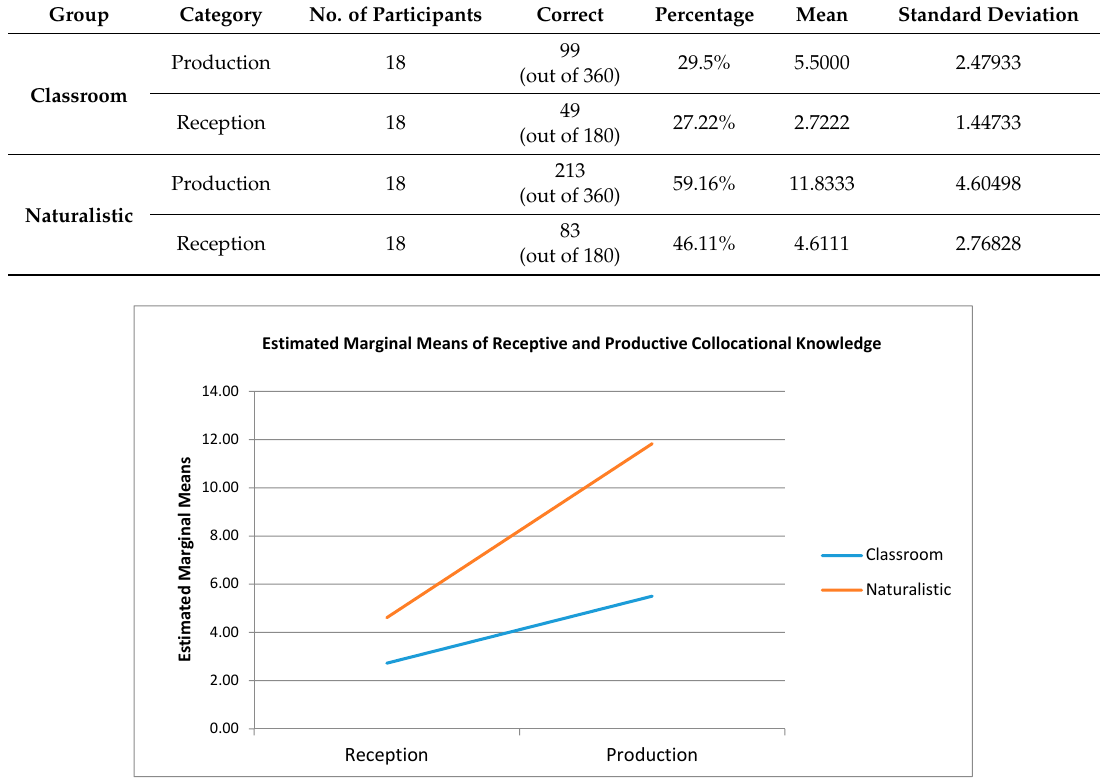
Figure 1. The Receptive and Productive Knowledge of Collocation for the Two Groups.